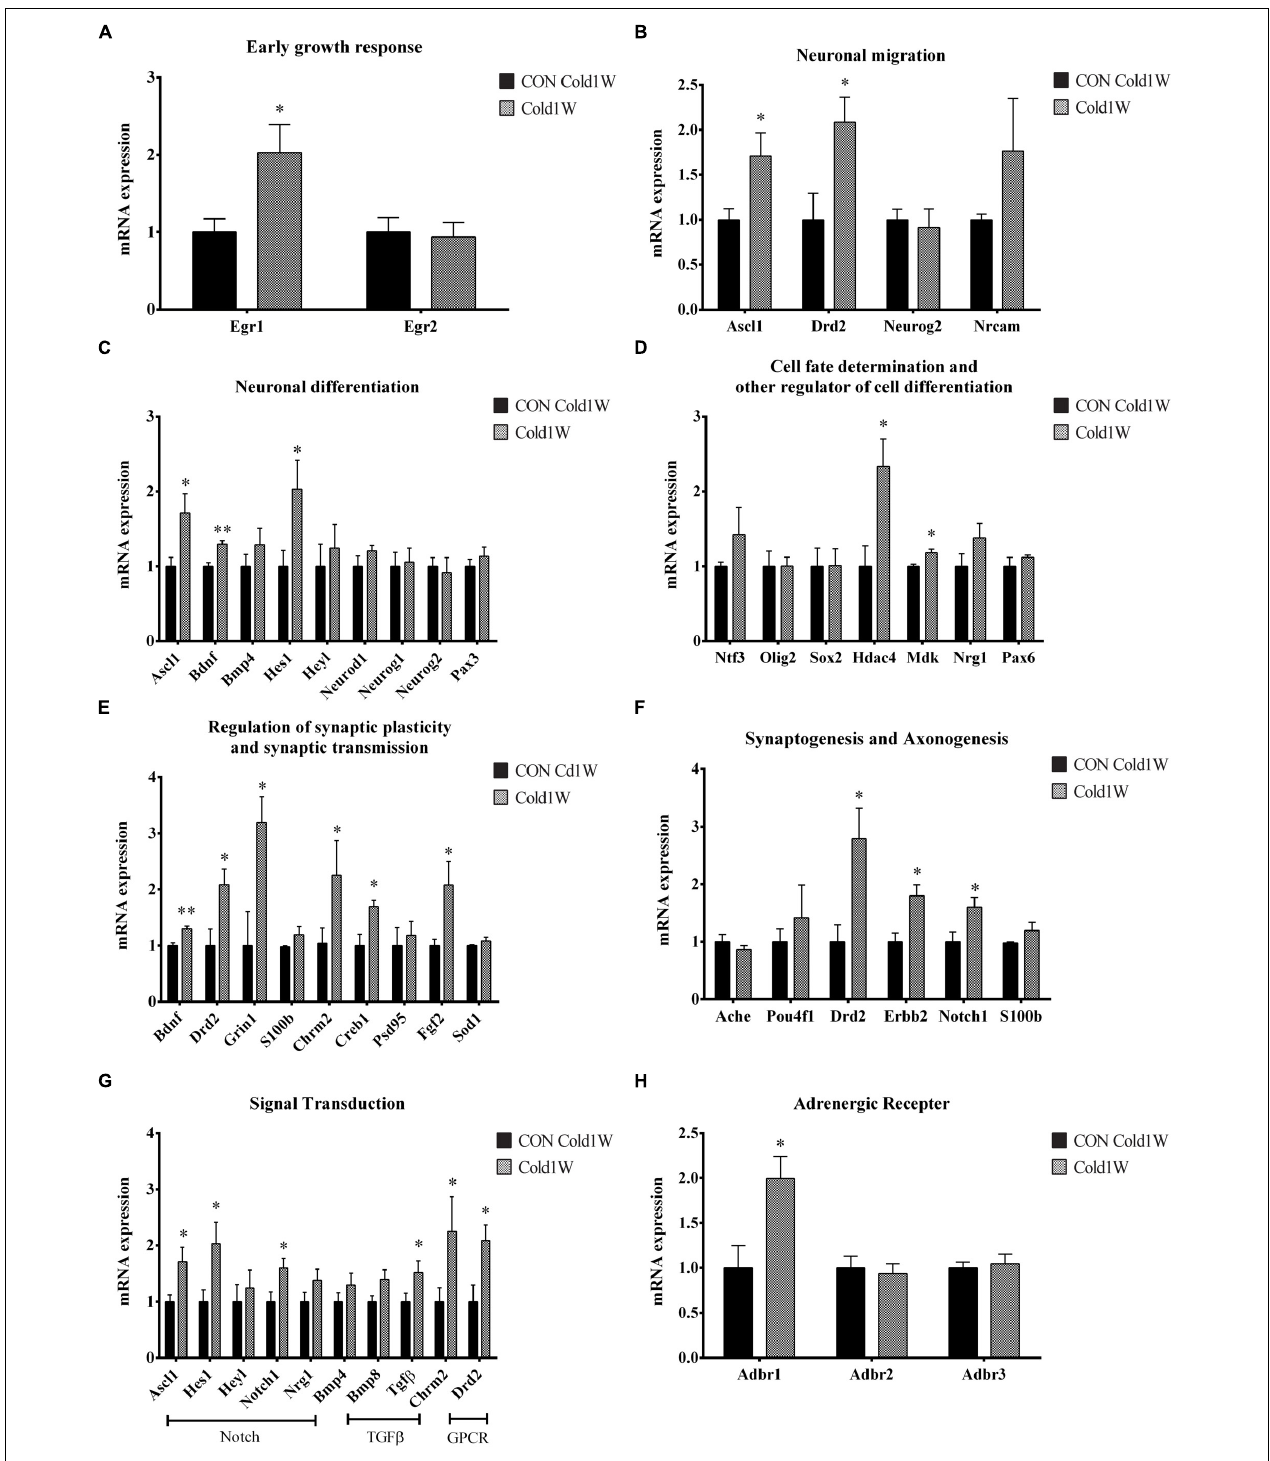
FIGURE 5 | Effects of 1 week cold challenge on the expression levels of mRNA related to AHN, AHN-related signal transduction, and β -adrenergic receptor. Cold challenge for 1 week increased several genes related to (A) early growth response, (B) neuronal migration, (C) neuronal differentiation, (D) cell fate determination and other regulator of cell differentiation, (E) regulation of synaptic plasticity and synaptic transmission, (F) synaptogenesis and axonogenesis, (G) AHN-related to signaling transduction and (H) β -adrenergic receptor. ∗ indicates a significant difference when compared with the CON group ( p < 0.05); ∗∗ indicates a significant difference when compared with the CON group ( p < 0.01). Data are shown as mean + SEM.